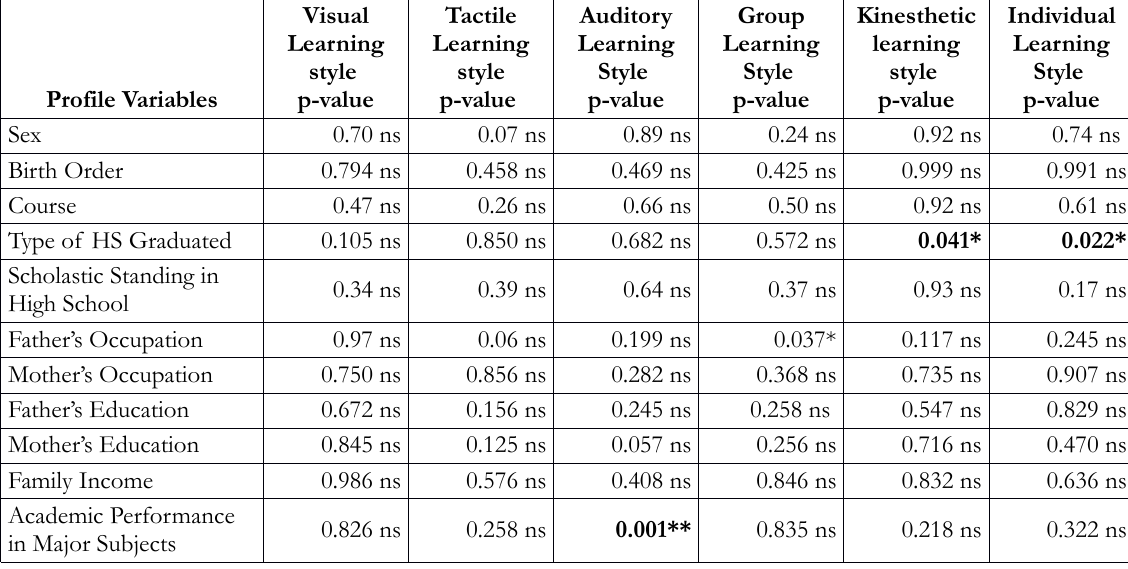
Table 4. Test of Difference on the Learning Style Preference of the